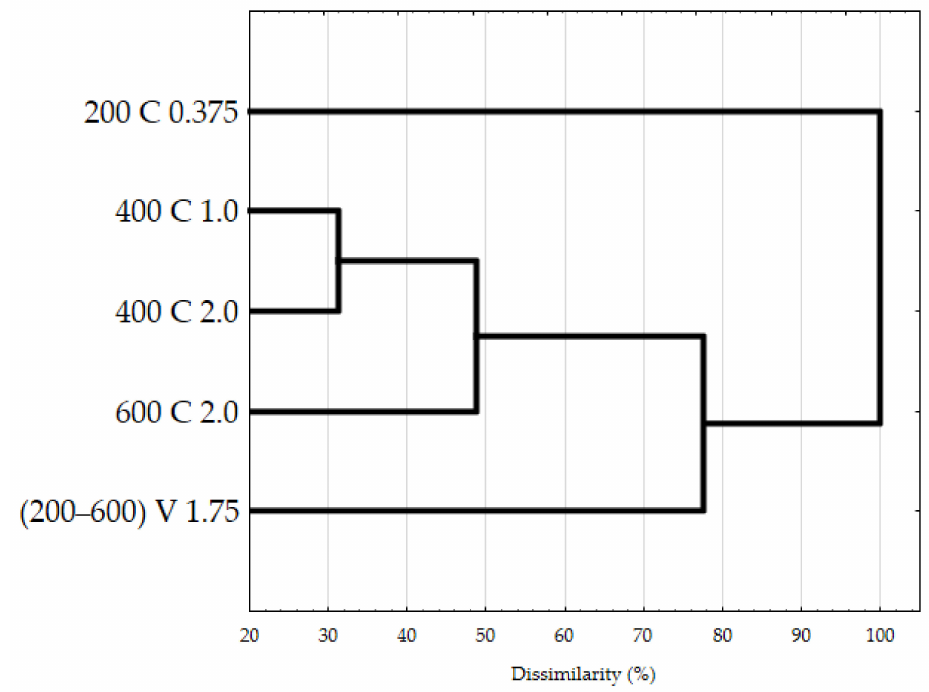
Figure 6. The results of the cluster